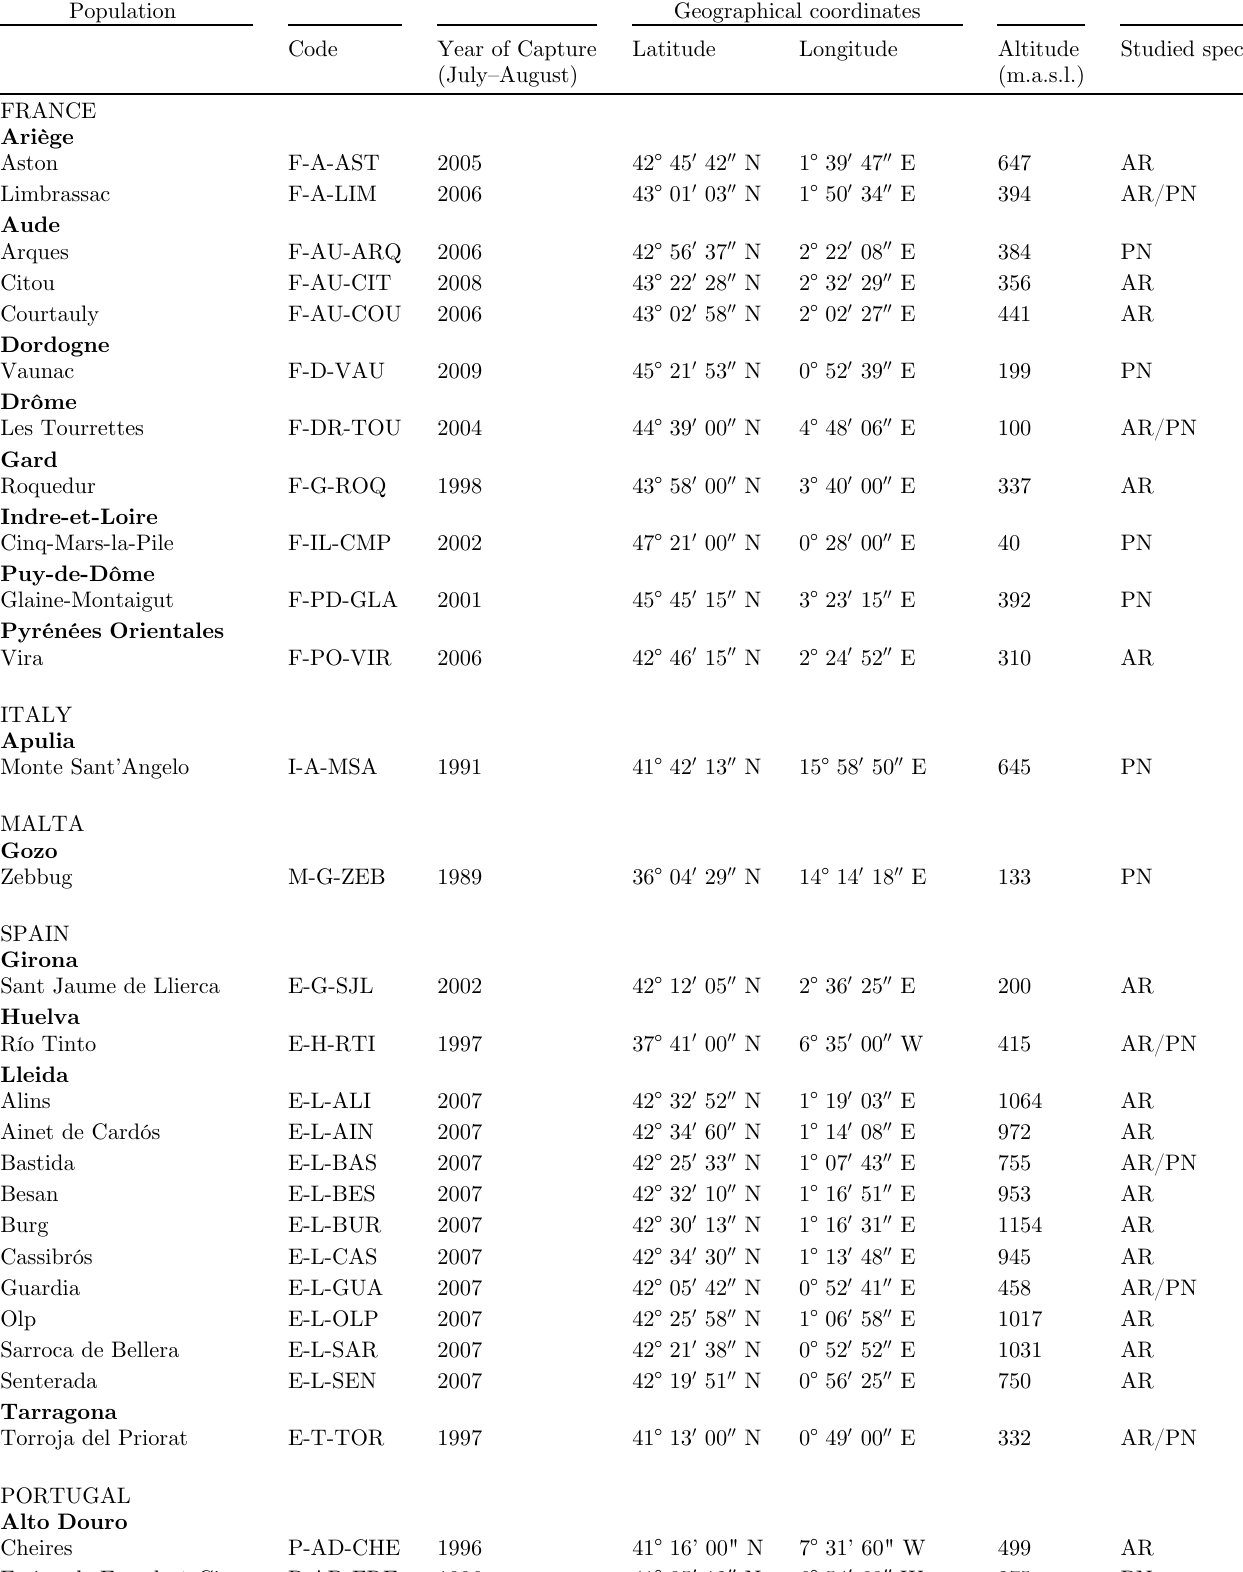
Table 1. Code, year of capture, geographical coordinates and altitude of the populations studied. AR: Phlebotomus ariasi ; PN: P. perniciosus